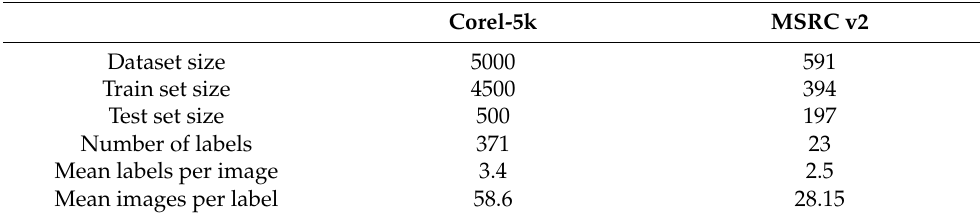
Table 1 lists the essential characteristics of the two datasets used. Table 1. Specifications of the two datasets used, Corel-5k and MSRC